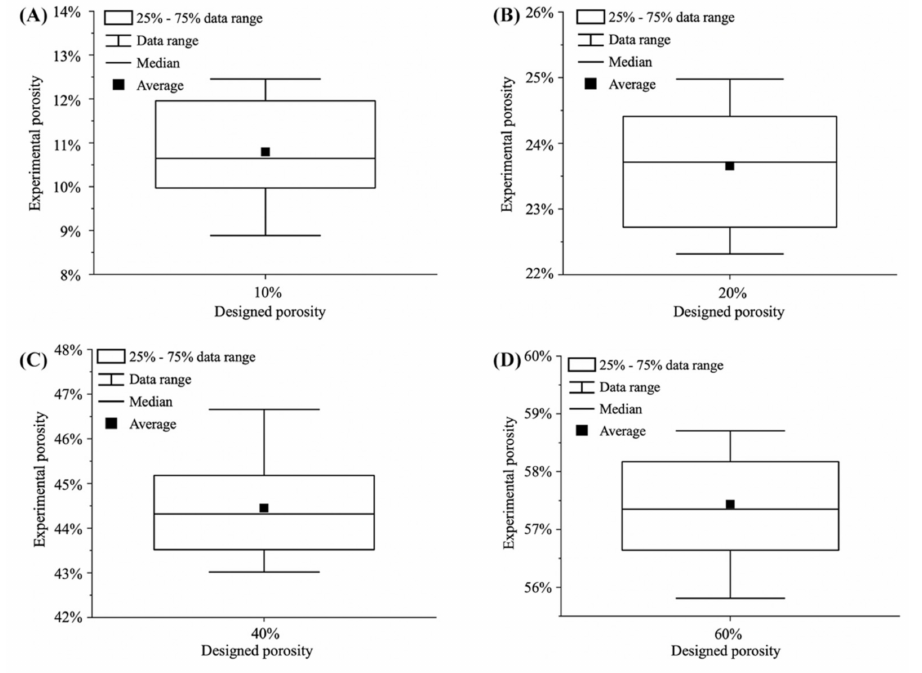
Figure 4. Designed porosity and experimental porosity of ( A ) 10%, ( B ) 20%, ( C ) 40%, and ( D ) 60% porosity NPG deposited biosensors. The error bar in the figure represents the data